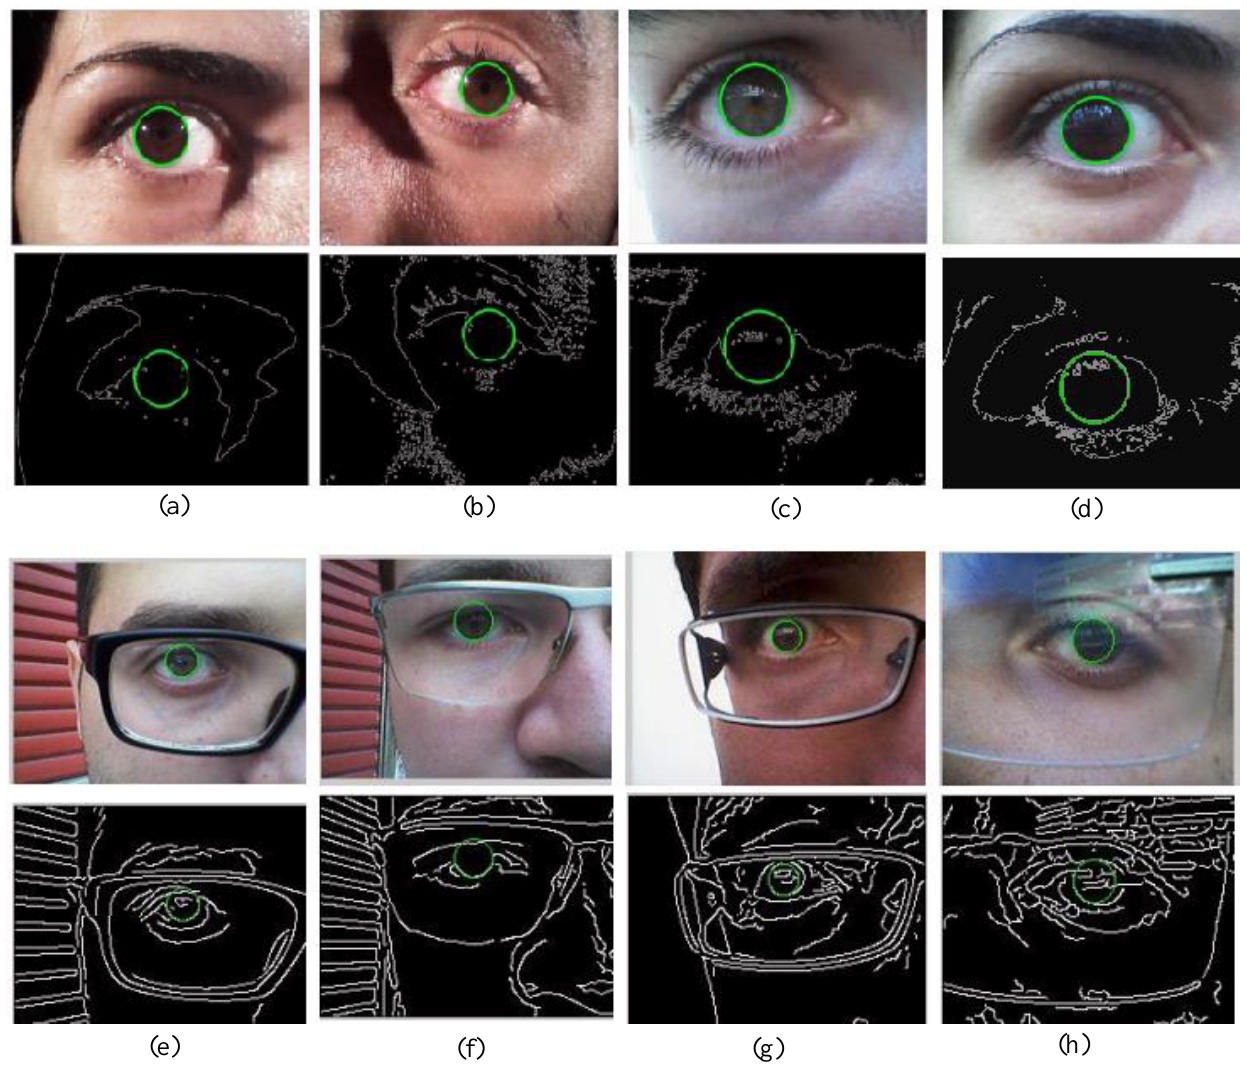
Figure 10. Results of iris detection on Galaxy Samsung Tab2